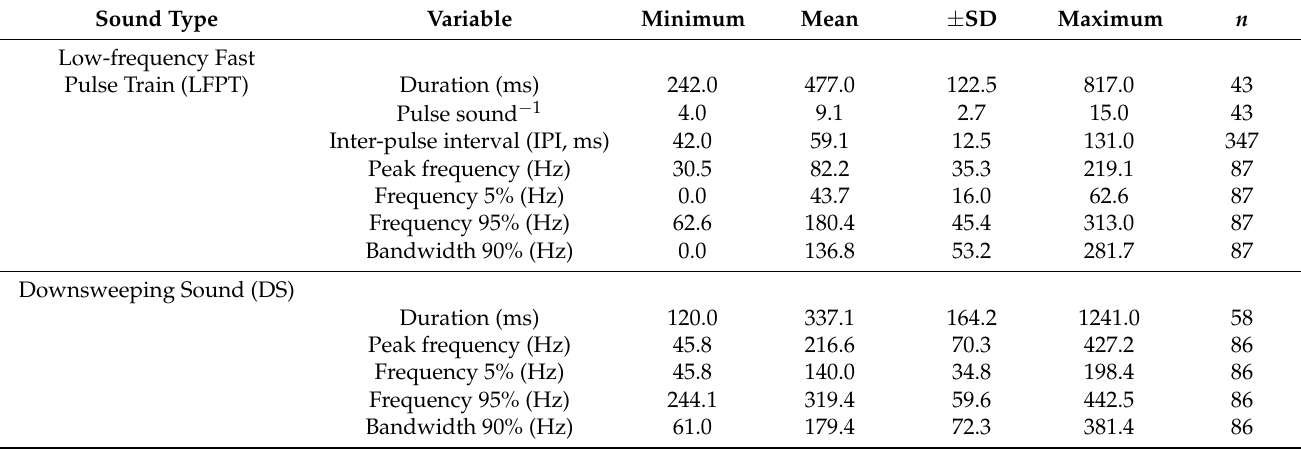
Figure 5. Pictures of three individuals of M. rubra displaying the three colour patterns known from the literature: ( A ) basic mottled pattern, ( B ) dark uniform pattern (presumptive female) and silver pattern (presumptive male). The behaviour displayed by the presumptive male in B is available in the Supplementary Materials Video S2b. Note, in B, the proximity of M. rubra individuals to the bottom, covered by mucilaginous aggregates, likely of the algae Acinetospora crinita . Table 3. Descriptive statistics of the two sound types likely produced by Mycteroperca rubra during courtship. Temporal measurements (duration and inter-pulse interval, IPI) were performed on the oscil- logram of the sounds, while frequency parameters were measured on the spectrogram (LFFT size = 256, Hann window, window overlap 50%); frequency 5% and frequency 95% are the frequencies dividing the sound selection into two frequency intervals containing, respectively, 5% and 95% of the energy in the selection; bandwidth 90% is the difference between the 5% and 95%